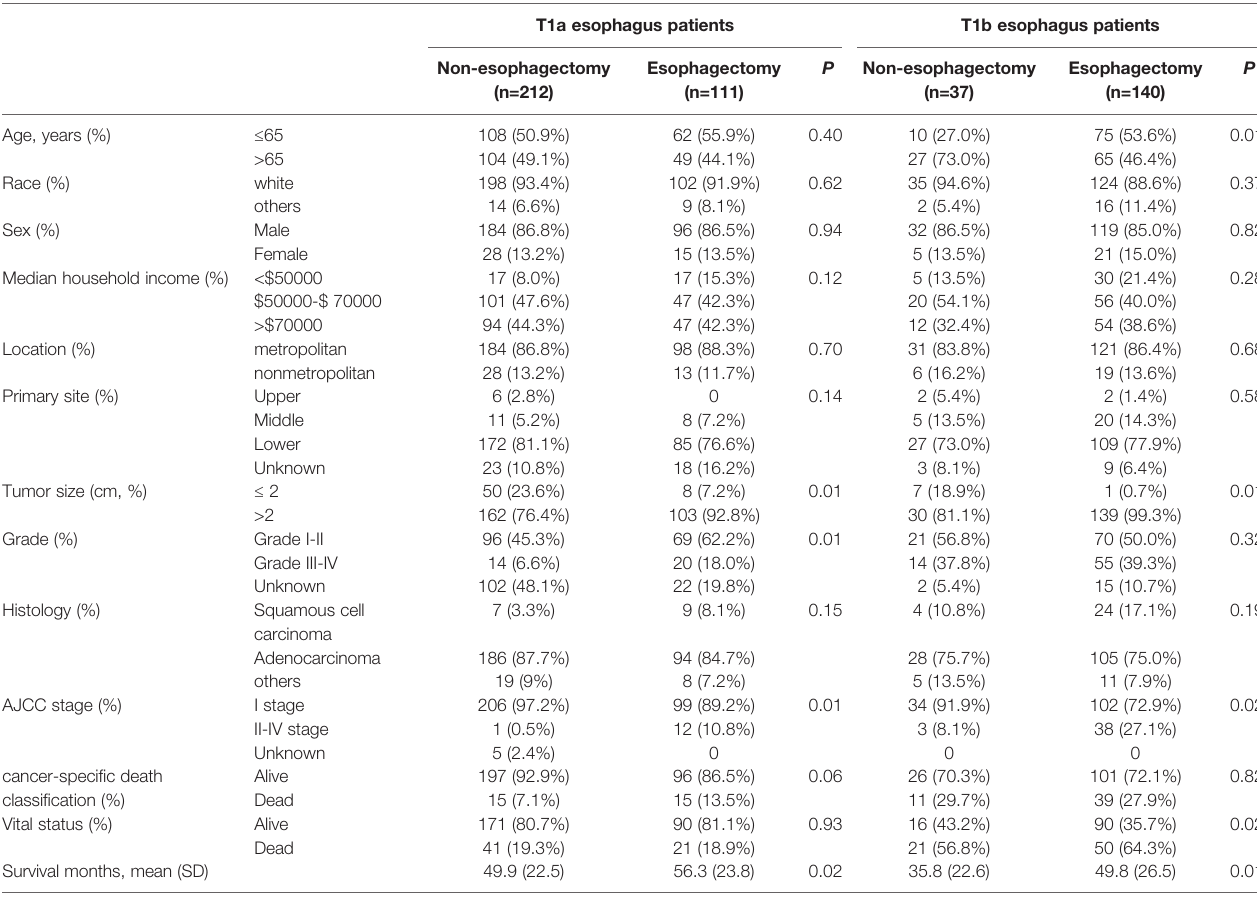
TABLE 3 | Baseline characteristics of T1a and T1b stage esophagus cancer patients with or without esophagectomy between 2005-2015. T1a esophagus patients T1b esophagus